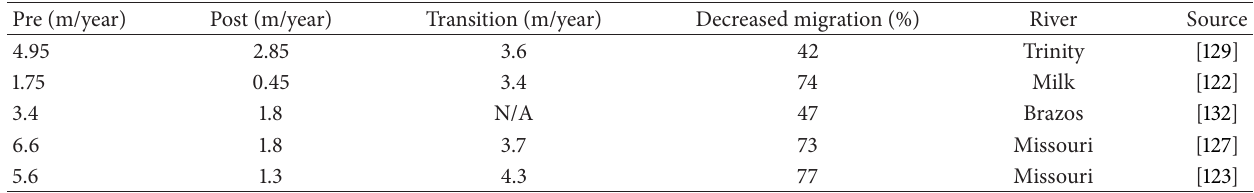
Table 2: Migration rates before and after damming from five rivers in the USA indicating suppressed lateral migration rates following regulation. Data from